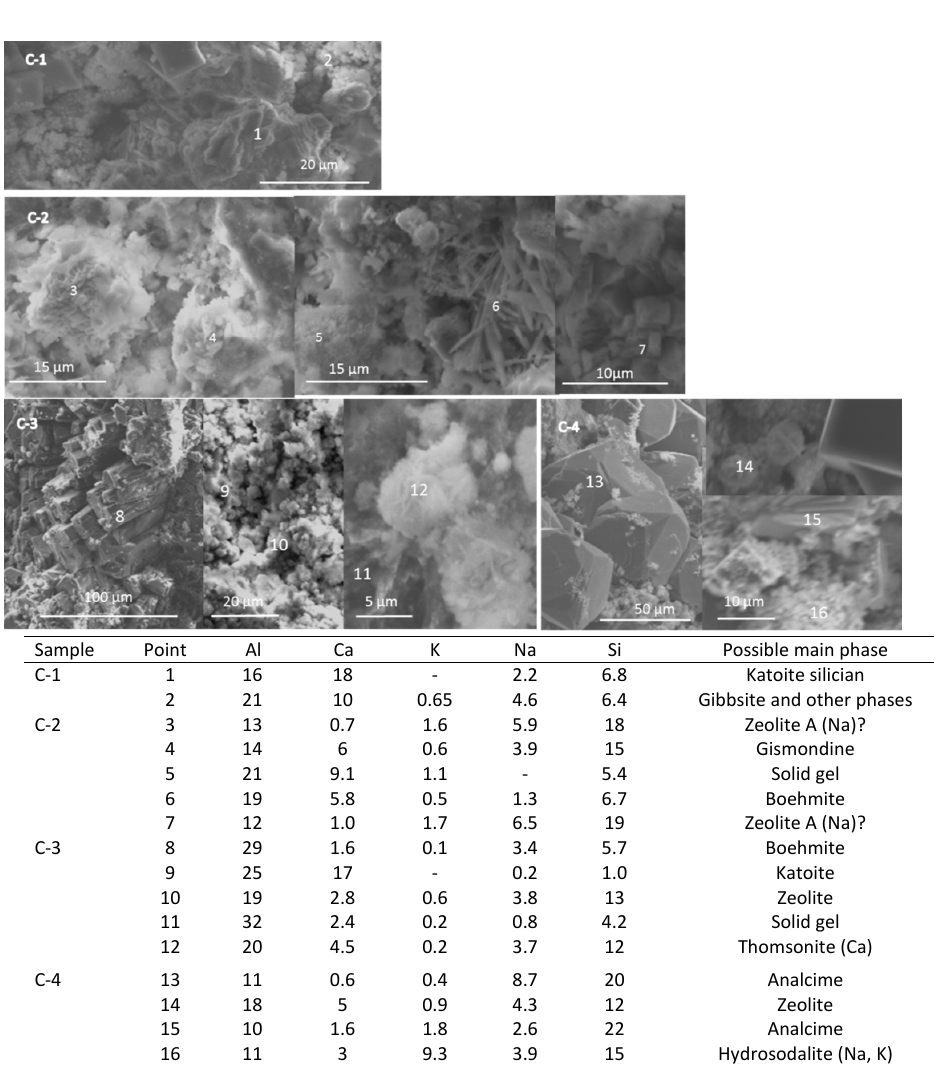
Figure 9. Scanning electron micrographs and point compositions of typical cement microstructures for control TSRC specimens without tartaric acid.